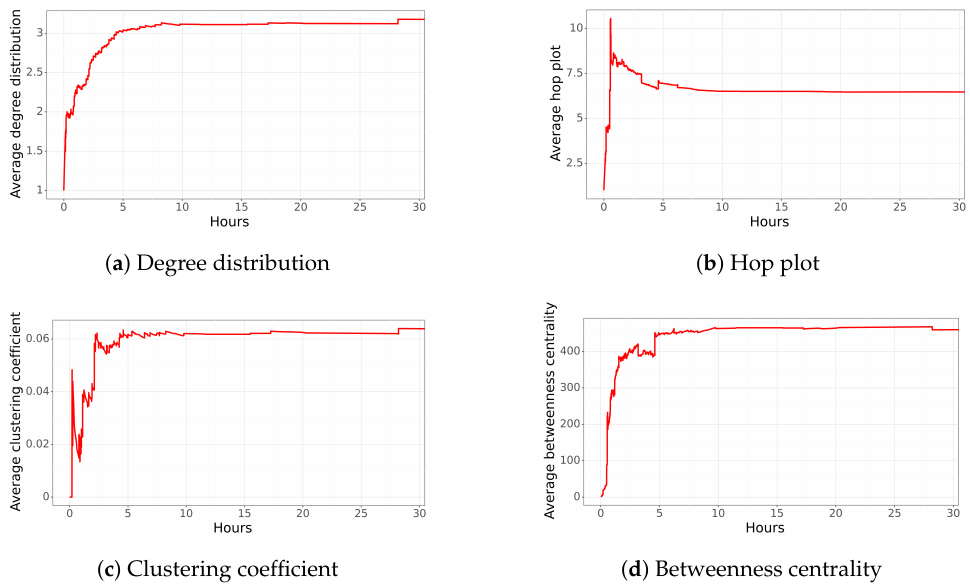
Figure 2. The average network characteristics for the tweet about the hairdresser of “La Roja” over time. The X-axes of these plots are reduced from 1 week to 30 h to improve